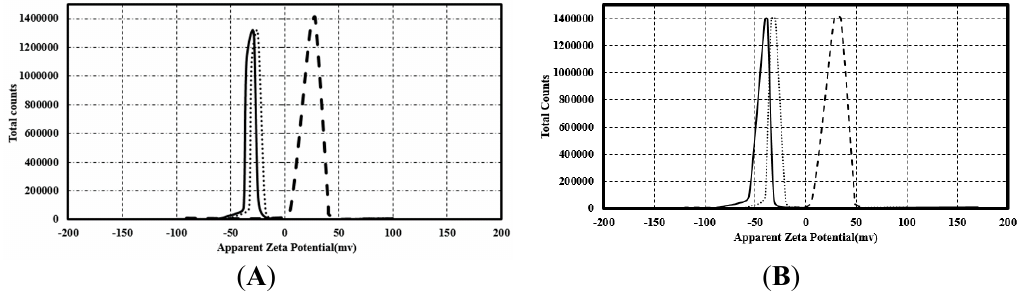
Figure 9. The apparent zeta potential (mV) of spherical ( A ) and prismatic ( B ) silver nanoparticles coated with citrate ( ─ ), PVP ( ∙∙∙ ) and poly-Arg-PVP ( - - ).